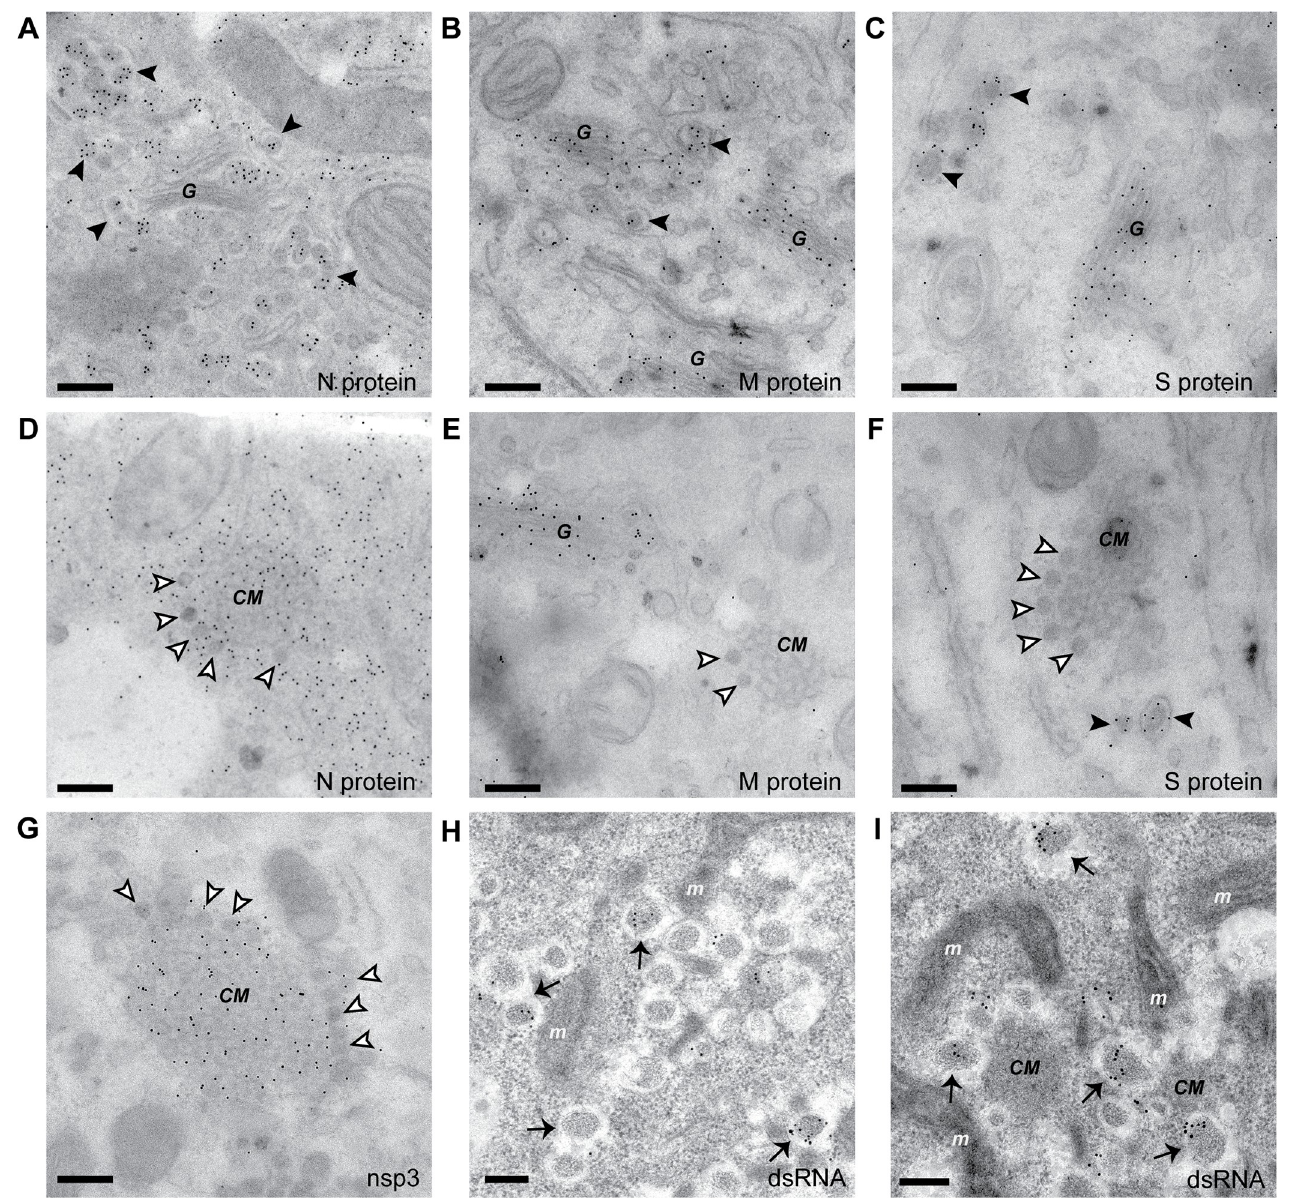
Fig 8. IEM detection of viral markers in MERS-CoV-infected cells. (A-G) Immunogold labeling of thawed cryo-sections of MERS-CoV-infected Huh7 cells (12 hpi) for the detection of the indicated viral proteins. (A-C) Structural proteins were detected on virions (black arrowheads) and, for the M and S proteins, also on Golgi cisterna. While regions containing DMS (white arrowheads) and CM labeled for the N protein (D) and nsp3 (G), the M and S protein were not detected in these areas. (H-I) Immunogold labeling of dsRNA in HPF-FS samples of MERS-CoV-infected Huh7 cells (13 hpi). The label accumulated on DMVs, which could be easily detected in this type of samples (black arrows), whereas the regions with CM and DMSs, which appeared as dark areas among the DMV clusters, were devoid of dsRNA signal. Scale bars, 250 nm. CM, convoluted membranes; DMS, double-membrane spherule; dsRNA, double-stranded RNA; G, Golgi complex; HPF-FS, high-pressure freezing, freeze-substitution; hpi, hours postinfection; IEM, immunoelectron microscopy; m, mitochondrion; MERS-CoV, Middle East respiratory syndrome-CoV; nsp3, nonstructural protein